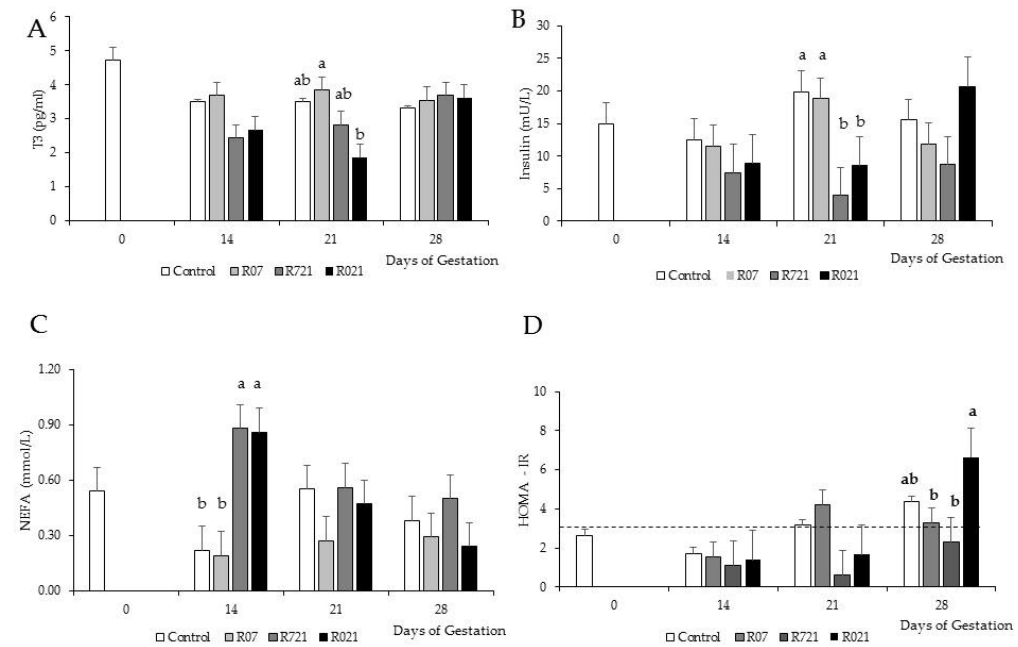
Figure 3. Effect of Maternal Feed Restriction and Time on ( A ) plasma triiodothyronine (T3), ( B ) insulin, ( C ) NEFA concentrations and ( D ) HOMA-IR during pregnancy of rabbits fed ad libitum (Control), restricted to 60% one week from day 0 to 7 (R07), two weeks from day 7 to 21 (R721) and three weeks from day 0 to 21 (R021) of gestation. (a–c): different letters indicate differences between experimental groups on each day of pregnancy ( p < 0.05). Each bar on day 14, 21 and 28 shows the mean of five does, and on day 0 is the mean of 10 does. The dashed line in (D) represents the value above which HOMA-IR indicates the presence of insulin resistance. Table 5. Effect of Maternal Feed Restriction (MFR) and Time on endocrine and metabolic parameters during lactation of rabbits fed ad libitum (Control), restricted to 60% one week from day 0 to 7 (R07), two weeks from day 7 to 21 (R721) and three weeks from day 0 to 21 (R021) of gestation.